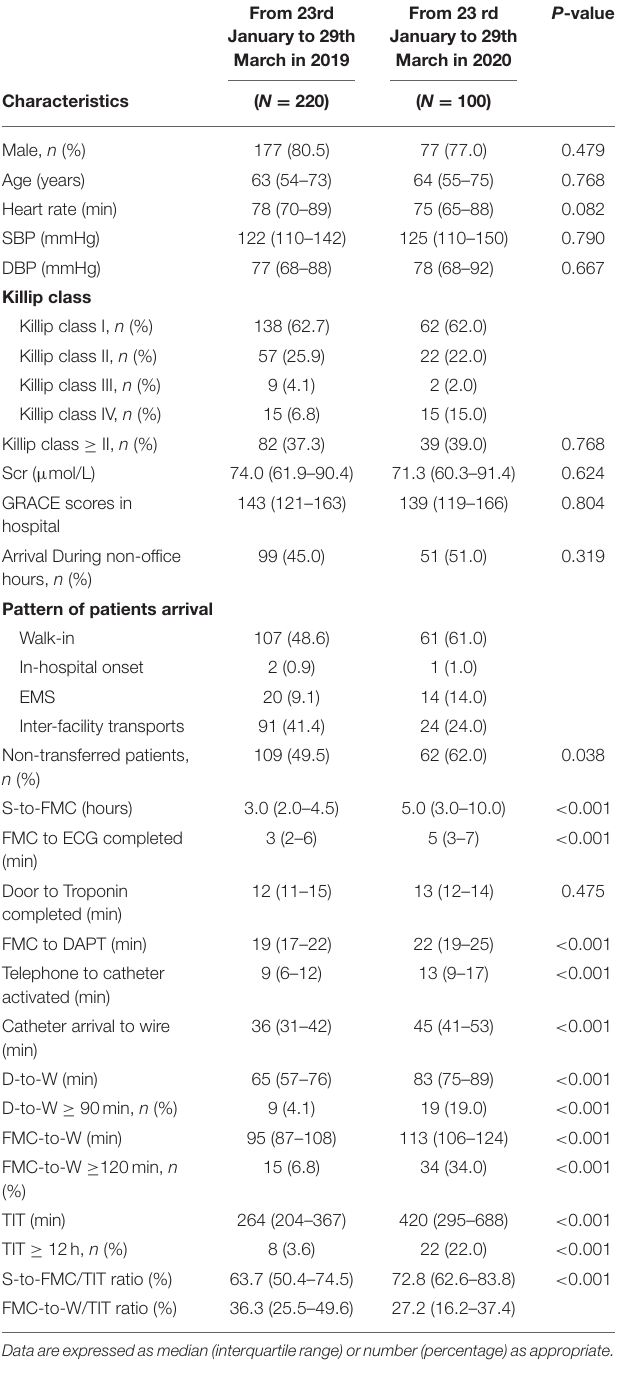
TABLE 1 | Characteristics of study population before and during COVID-19 pandemic.